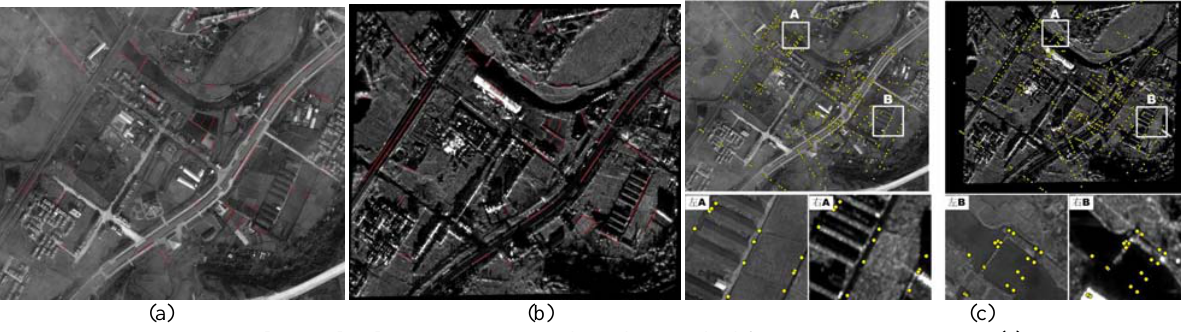
Figure 5. Registration result using level set segmentation and matching method for sequence SAR image 3. (a) Line segments extraction for optical image. (b) Line segments extraction for SAR image. (c) Set of tie points for optical (left) and SAR image (right).